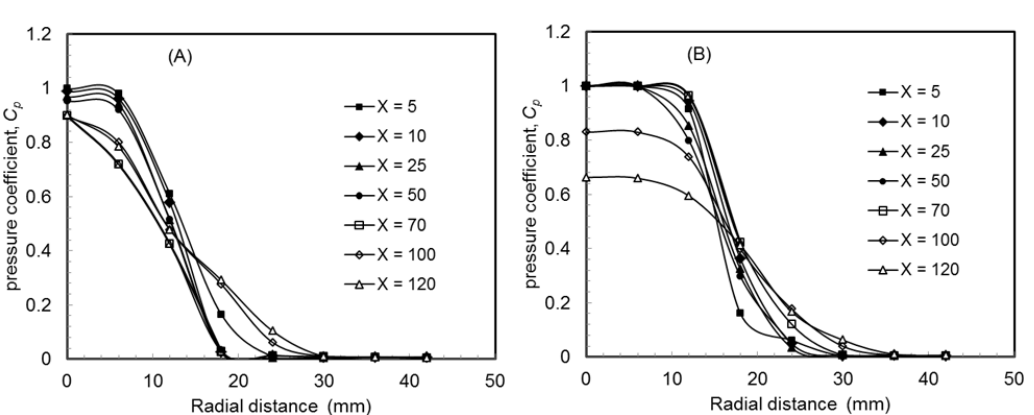
Figure 7. Radial pressure coefficients distribution at different axial distances from the orifice (jet velocity = 20 m/s). A) D = 10 mm, B) d = 20 mm.